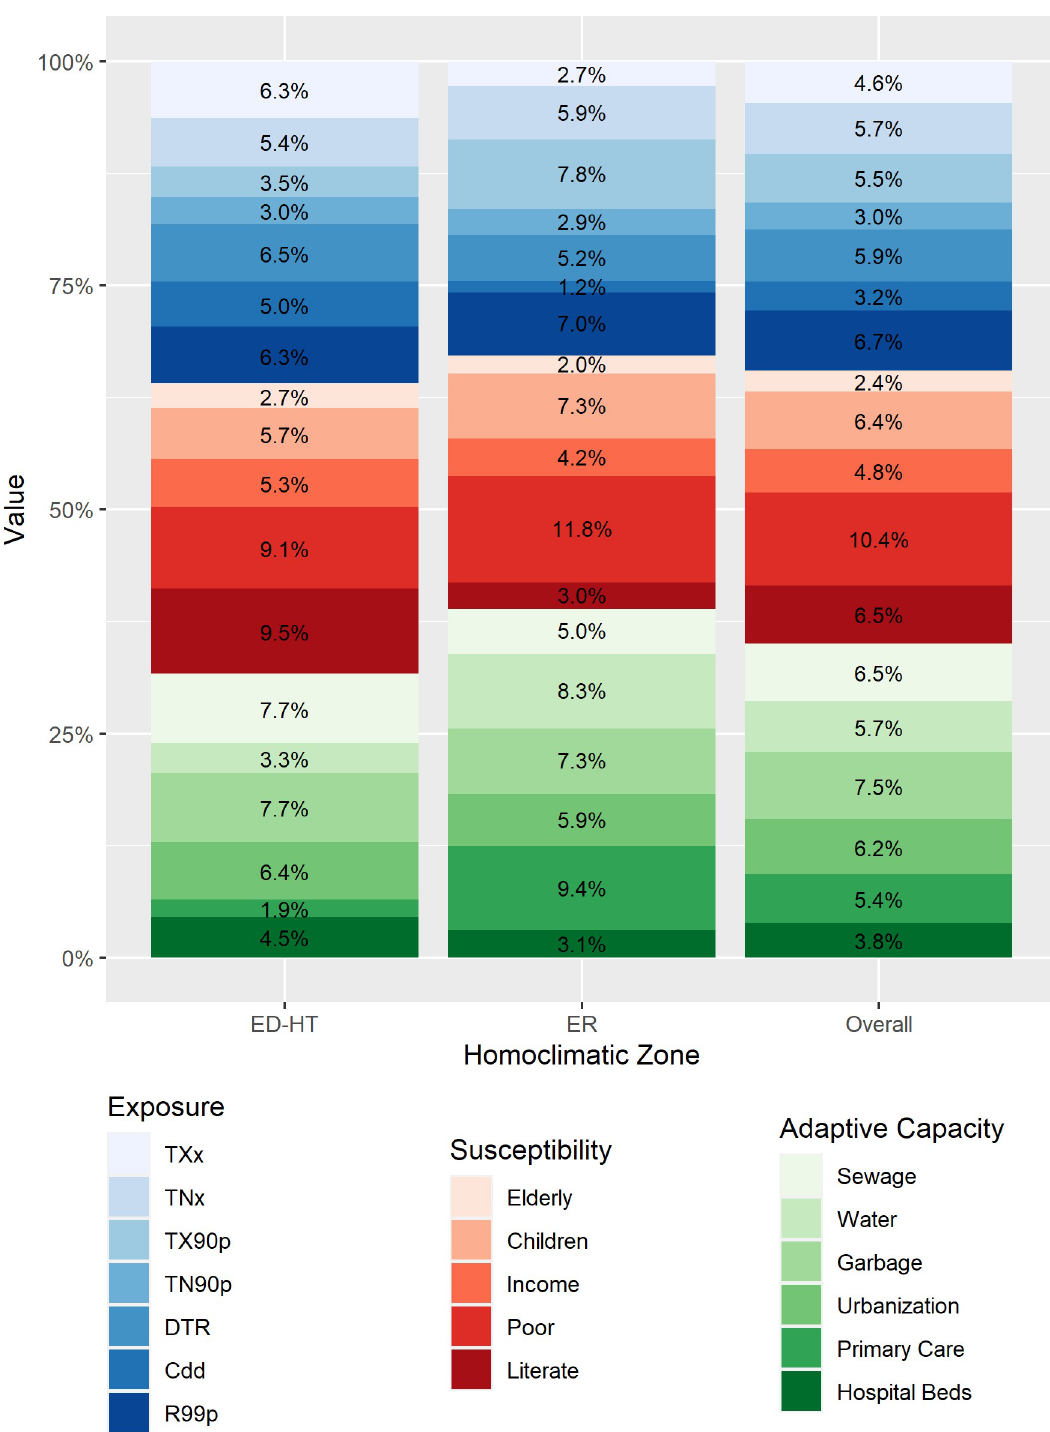
Fig 2. Percent contribution of each indicator to the ECVI by dimension and homoclimatic region (k = 0.25). TXx: Monthly maximum value of daily maximum temperature (oC), TNx: Monthly maximum value of daily minimum temperature (oC); TX90p: Percentage of warm days; TN90p: Percentage of warm nights; DTR: Daily temperature range; Cdd: Dry spell; R99p: Extremely wet days; ER: Extreme rain zones in the Brazilian Amazon and Northeast region; ED-HT: Extreme drought and high temperature in the Brazilian Amazon and Northeast region; ECVI: Extreme Climate Vulnerability Index.